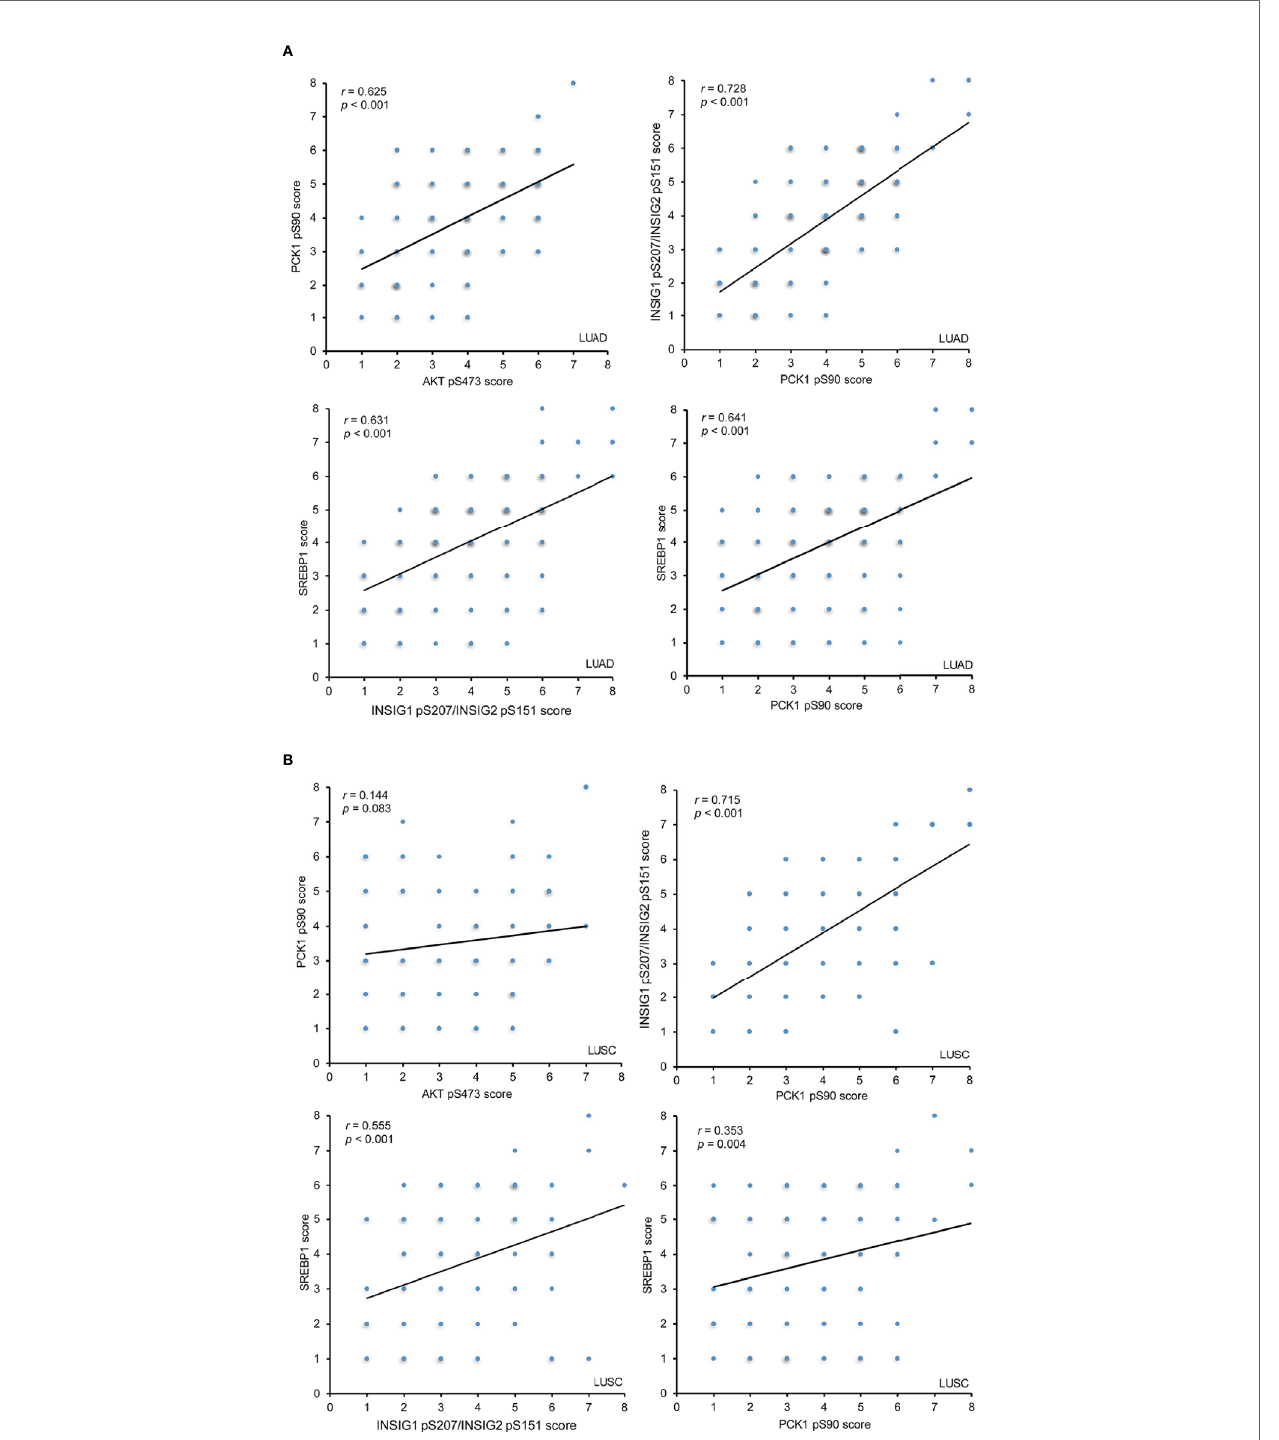
FIGURE 3 | The expression levels of AKT pS473, PCK1 pS90, INSIG1 pS207/INSIG2 pS151, and nuclear SREBP1 are positively correlated with each other in LUAD IHC staining of 451 NSCLC specimens was performed with the indicated speci fi city-validated antibodies. (A) The correlations between the expression levels of AKT pS473, PCK1 pS90, INSIG1 pS207/INSIG2 pS151, and nuclear SREBP1 in LUAD specimens. (B) The correlations between the expression levels of AKT pS473, PCK1 pS90, INSIG1 pS207/INSIG2 pS151, and nuclear SREBP1 in LUSC